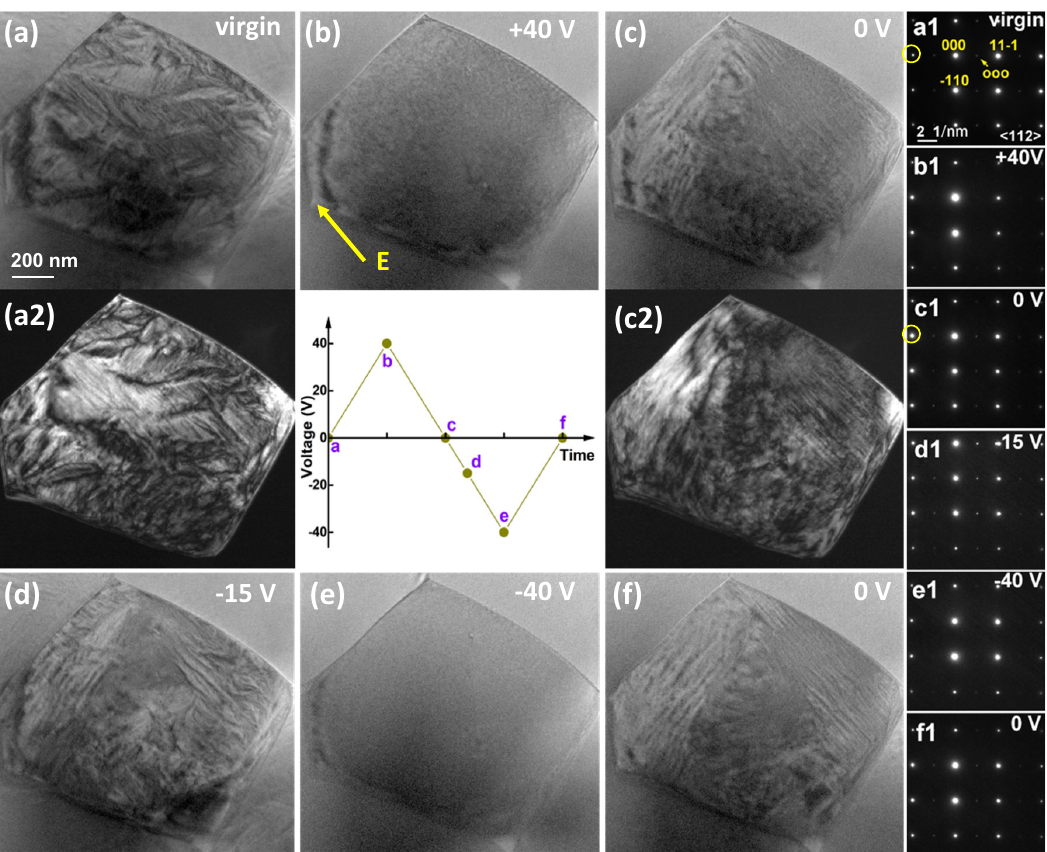
Fig.4|DomainmorphologyofthePL 8.3 Z 66 T 34 ceramicunderdifferentelectric fi eldconditionsatroomtemperature.a virgin, b 40V, c 0V, d − 15V, e − 40V, f 0V,and a1 – f1 corresponding SAED. Dard fi eld images for the a2 virgin and c2 poled states by using the circled diffraction spots in a1 and c1 ,